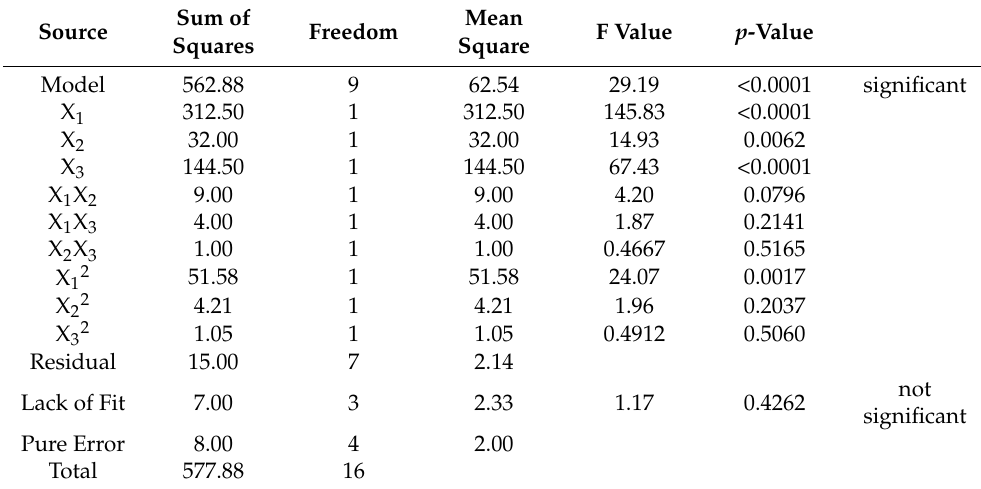
Table 4. Significance test for variance analysis and coefficient constants of regression models.